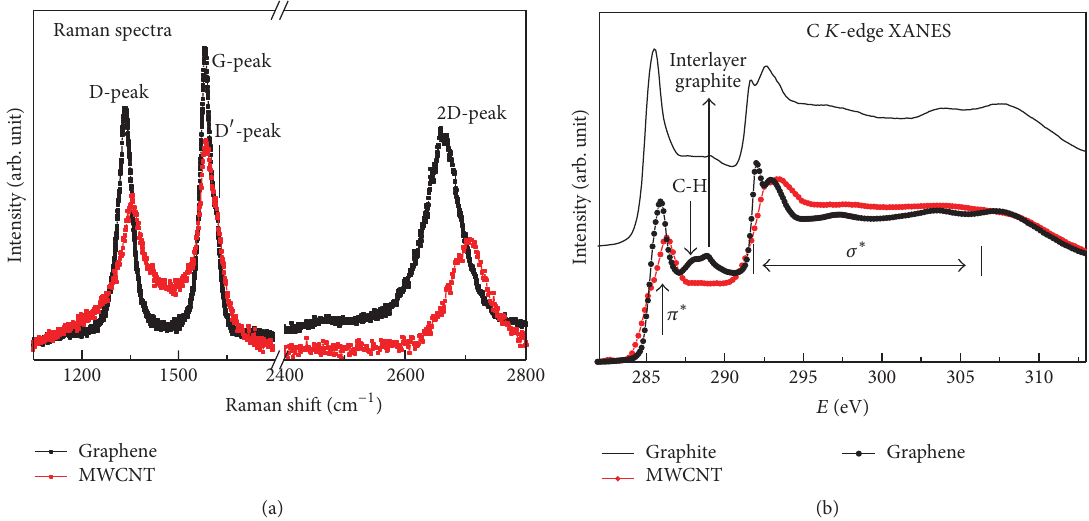
Figure 2: Raman spectroscopy of (a) FLG and MWCNTs and C K -edge XANES spectroscopy of (b) FLG and MWCNTs along with graphite as a reference.